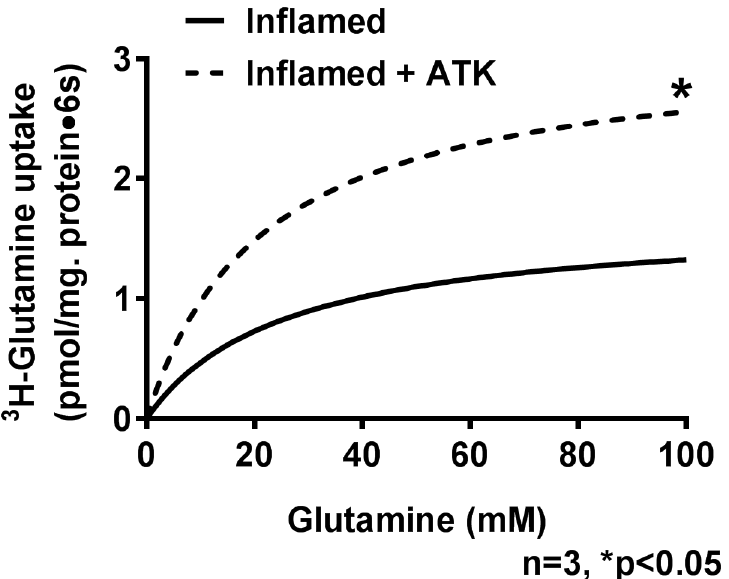
Fig 3. A representative graph of kinetics of glutamine uptake in villus BBMV. As the concentration of extravesicular glutamine was increased the uptake of glutamine also increased and became saturated in both inflamed and inflamed+ATK, as shown in the above figure.